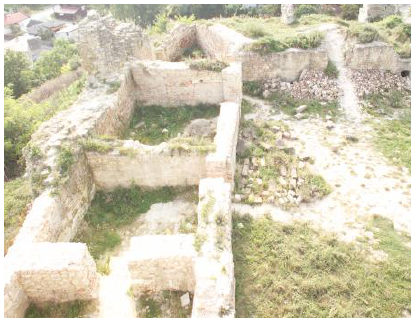
Figure 2. Walls of castle ruins